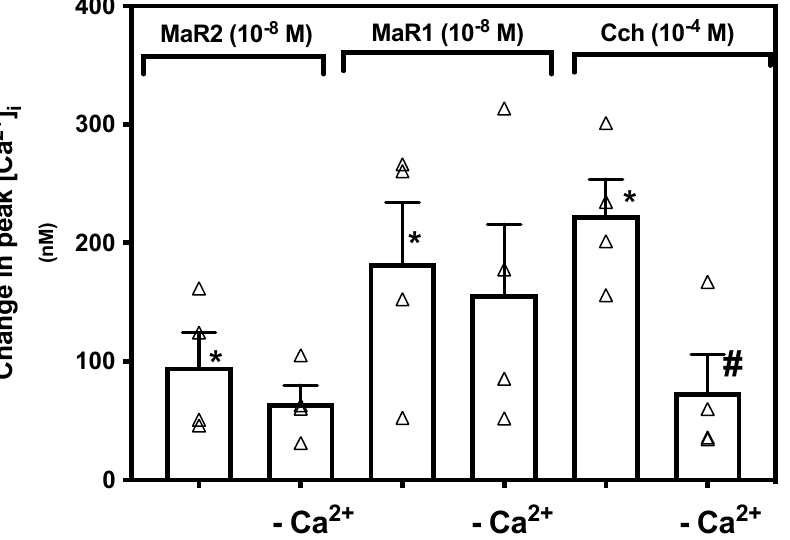
Figure 6. Maresin 2 stimulated increase in [Ca 2+ ] i is independent of extracellular Ca 2+ in rat conjunc- tival goblet cells. Goblet cells were incubated with vehicle with or without CaCl 2 , then stimulated with MaR2 (10 − 8 M), or the controls MaR1 (10 − 8 M) and Cch (10 − 4 M). Figure shows changes in peak of [Ca 2+ ] i . Data are mean ± SEM of four experiments. White triangles indicate individual data points. * shows significance above basal. # shows significance between agonist and extracellular Ca 2+ removal then agonist.